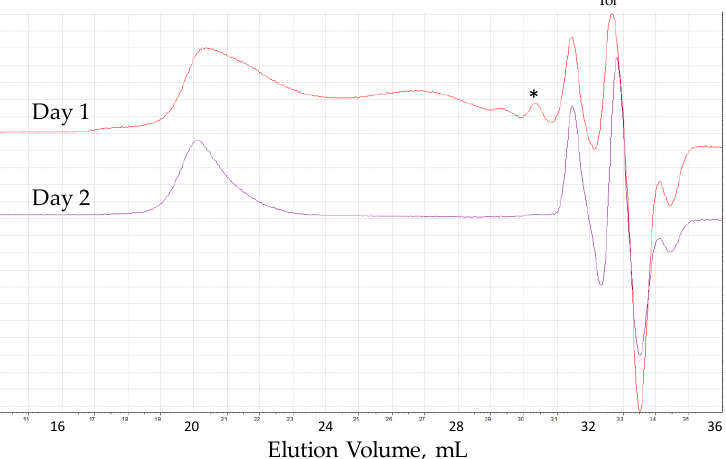
Figure 6. Size-exclusion chromatography dRI traces of products extracted with CHCl 3 from PSt- VBzGG-3 SIPN over 24 and 48 h. (*)—unreacted styrene, (Tol)—toluene flow rate marker.